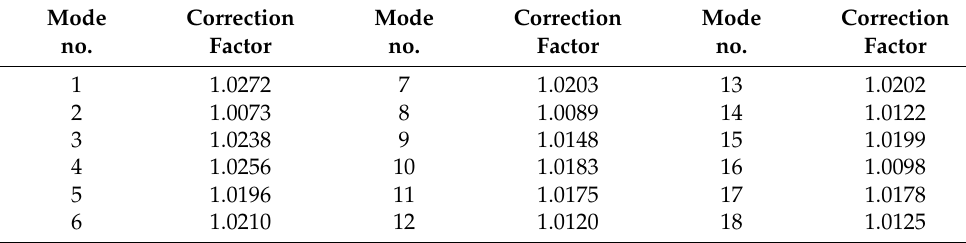
Table 2. Correction factors for adapting FEM eigenfrequencies to ART data.